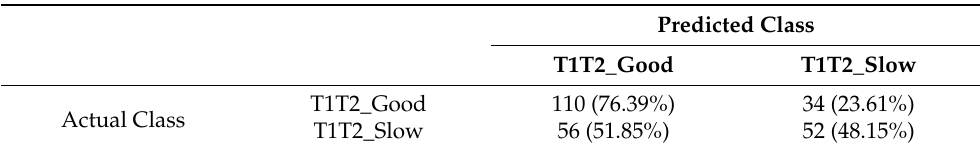
Table 3. Classification table in classification and regression tree (CART) analysis for T1T2 Re- engagement